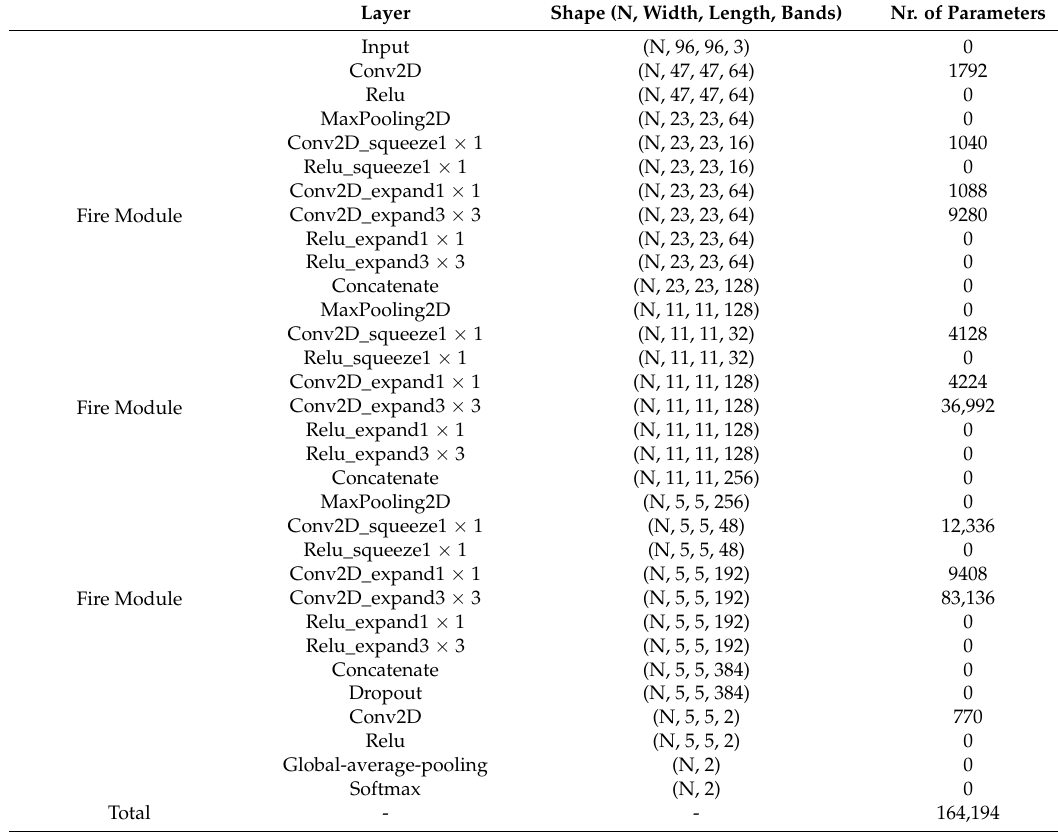
Figure 5. The structure of the Fire module used in SqueezeNet. Table 1. The CNN structure adopted in this